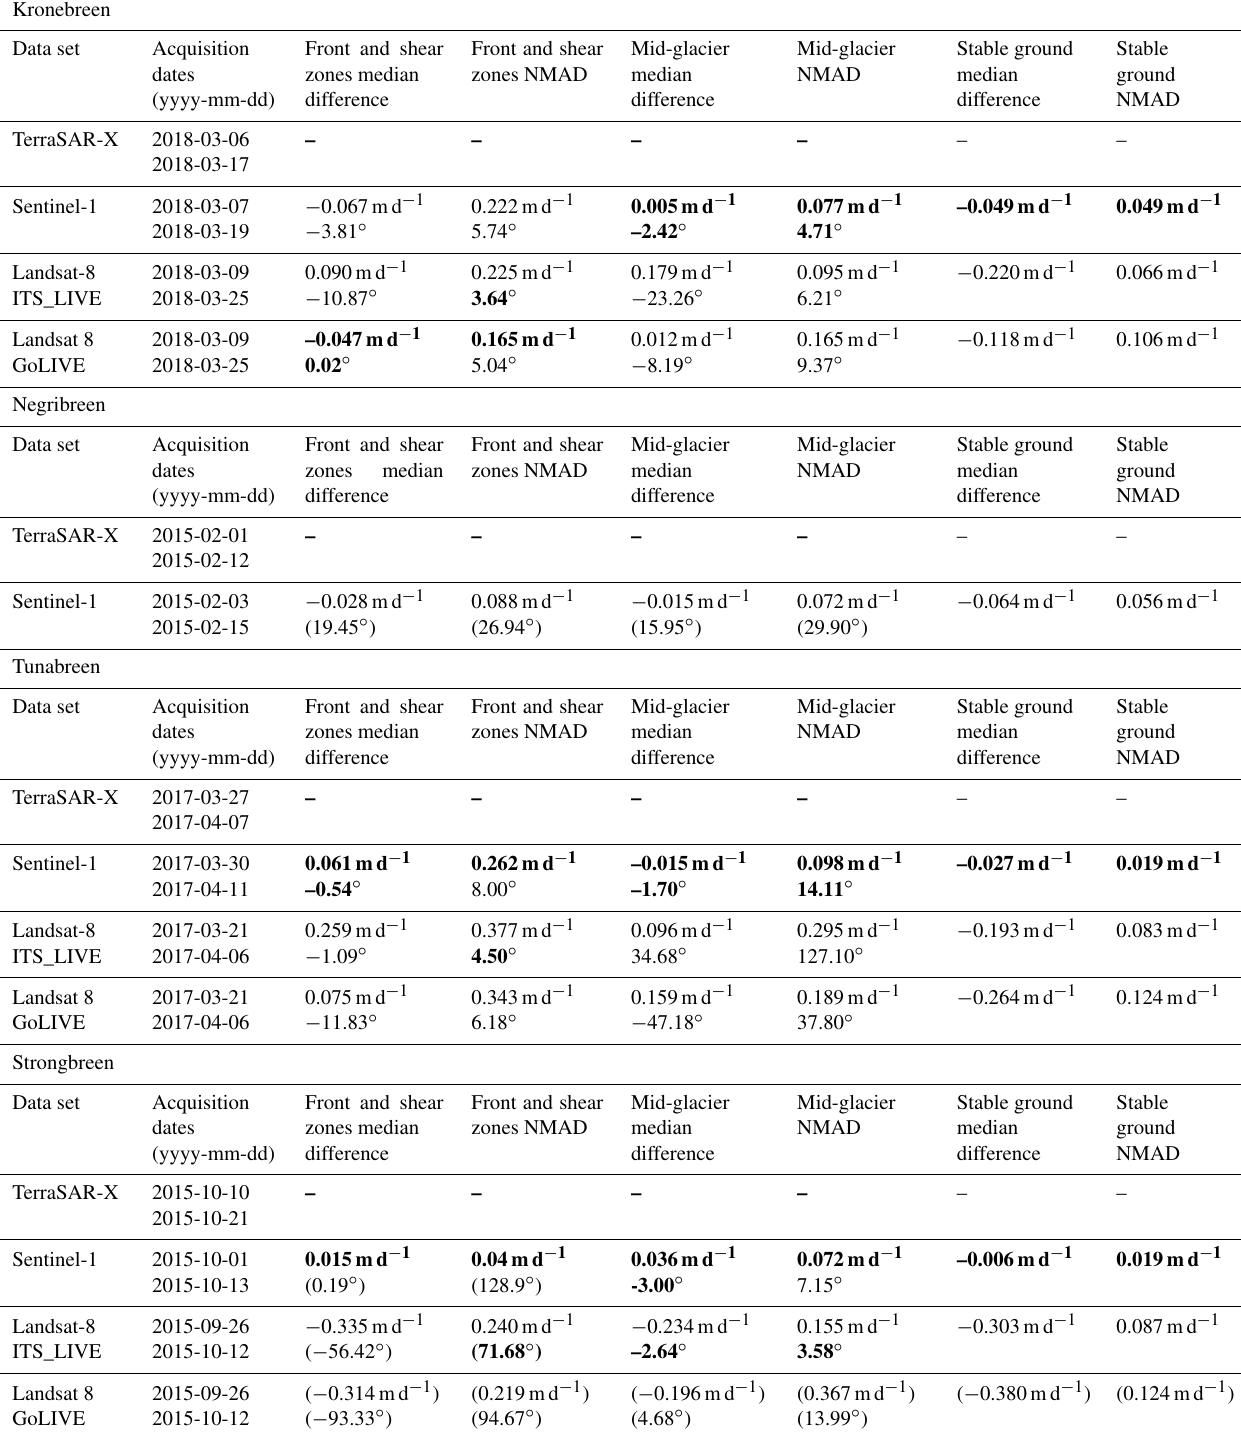
Table 1. Results of the intercomparison experiment of Sentinel-1, Landsat-8 ITS_LIVE and Landsat-8 GoLIVE ice velocity and displacement angle fields with TerraSAR-X. The corresponding extraction areas are shown in Fig. 7. Minimum differences to TerraSAR-X are highlighted as bold